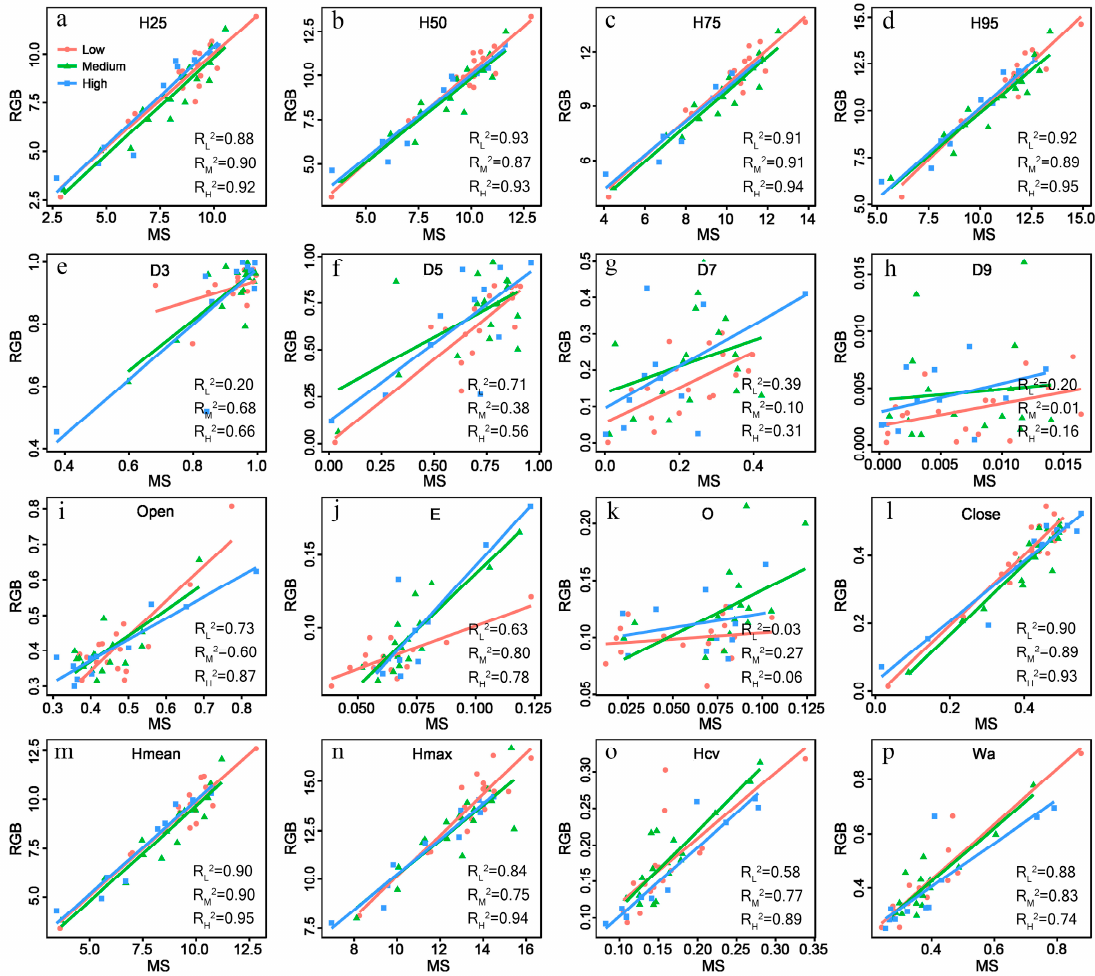
Figure 6. Scatterplots of structural metrics extracted from the point clouds derived from UAS multispectral and RGB data (the plots with low, medium, and high stem density are shown in different colors). ( a ) H25; ( b ) H50; ( c ) H75; ( d ) H95; ( e ) D3; ( f ) D5; ( g ) D7; ( h ) D9; ( i ) Open; ( j ) E; ( k ) O; ( l ) Close; ( m ) Hmean; ( n ) Hmax; ( o ) Hcv; ( p ) W α .